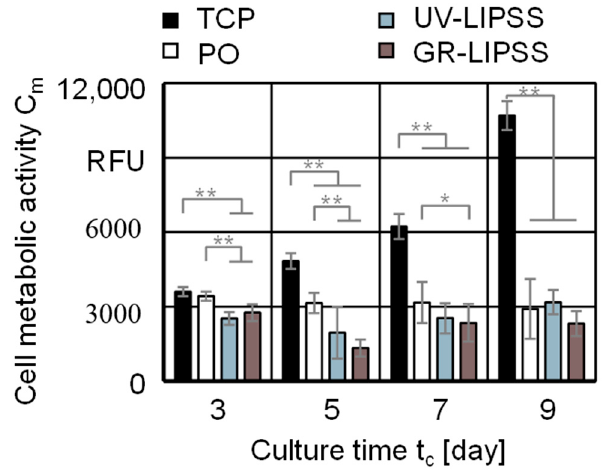
Figure 4. Cell metabolic activity C m on tissue culture plastic (TCP), PO, UV-LIPSS, and GR-LIPSS. Statistical analysis by ANOVA and Tukey’s test for determination of statistically significant differences (n = 5 each group, * for p < 0.05, ** for p < 0.01).